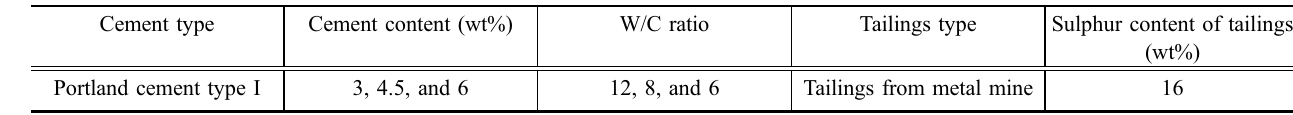
Fig. 11 Effect of sulphate content on CPB strength: a changes to CPB strength with curing time and b correlation between predicted results and measured CPB strength values. Table 6 Mixture recipe adopted in Case Study